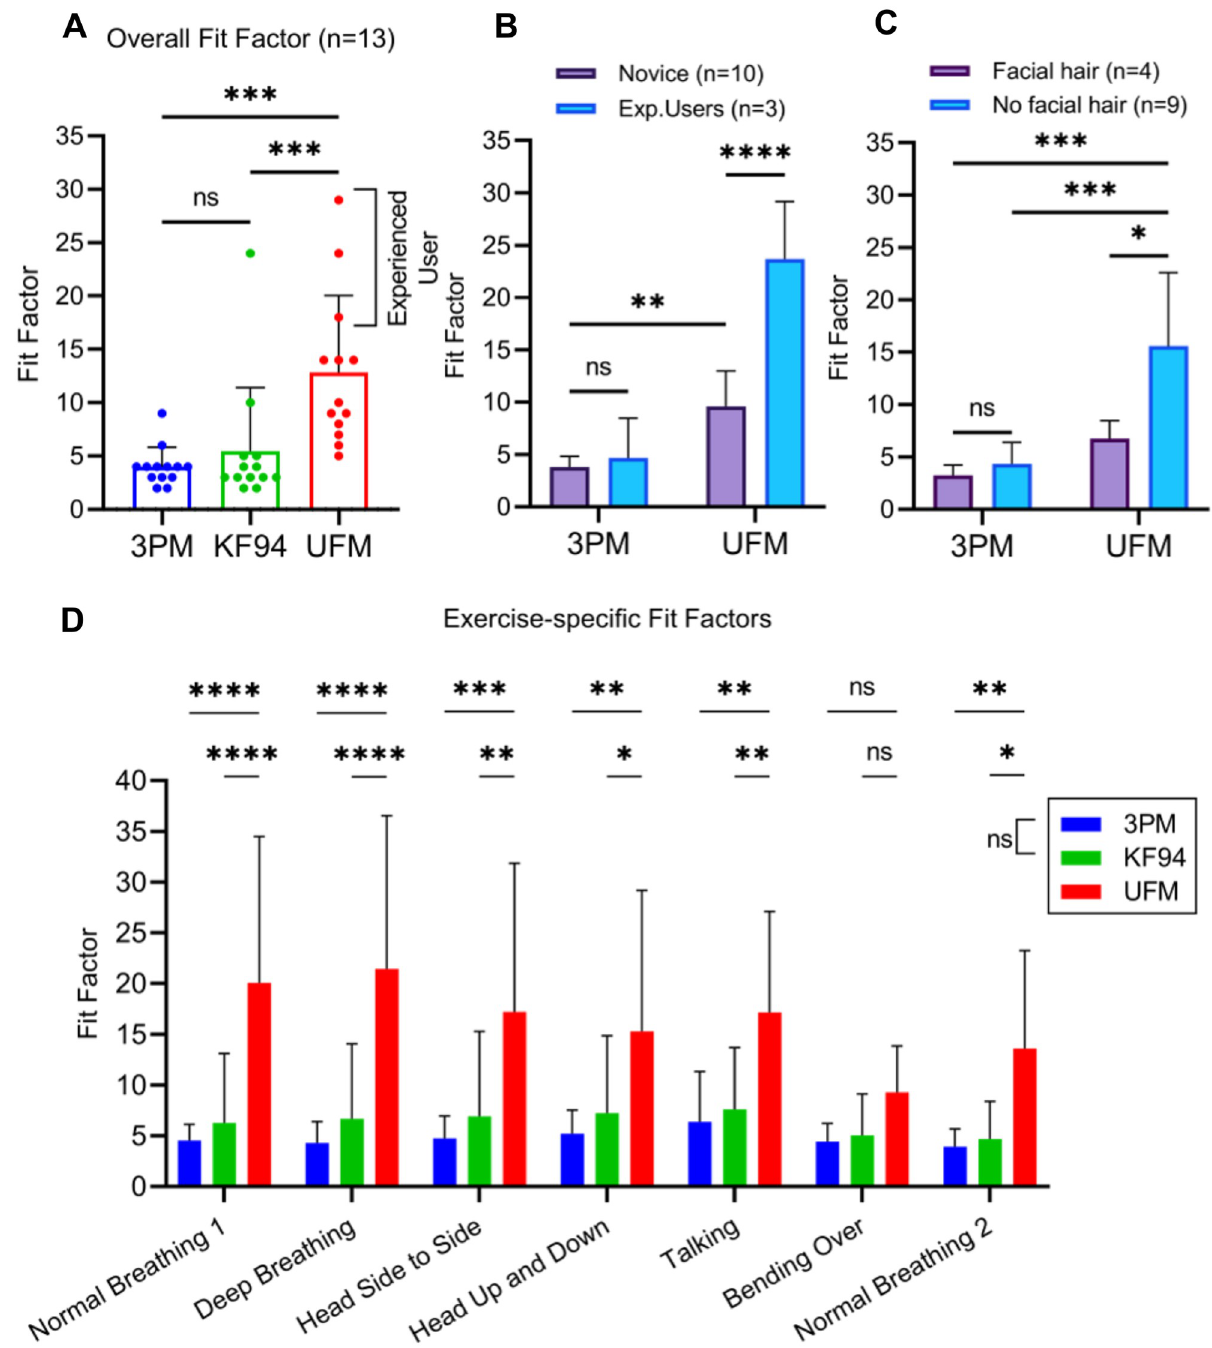
Fig 5. Quantitative fit test results of 3PM, KF94 and UFM. (A) Overall fit factors of quantitative fit test by PortaCount 1 8038 for n = 13 volunteers with 3PM, KF94 and UFM. (B) Fit factors between novice (n = 10) and experienced users (n = 3). (C) Effects of facial hair with 3PM and UFM groups. UFM with no hair outperformed both 3PM with and without hair and as well as UFM with hair. was used. (D) Exercise-specific fit factors measured with PortaCount 1 8038 of 3PM, KF94 and UFM. After reading a provided rainbow passage (‘Talking’), a non-measuring grimace exercise was performed per the OSHA fit test protocol. The post-grimace normal breathing exercise was labelled as ‘Normal Breathing 2’ to differentiate from the earlier normal breathing (‘Normal Breathing 1’). Bars are of the mean with error bars indicating the standard deviation. A Friedman test was performed for statistical analysis. � , �� , ��� , and ���� indicate adjusted p-values of less than 0.05, 0.01, 0.001, and 0.0001, respectively.